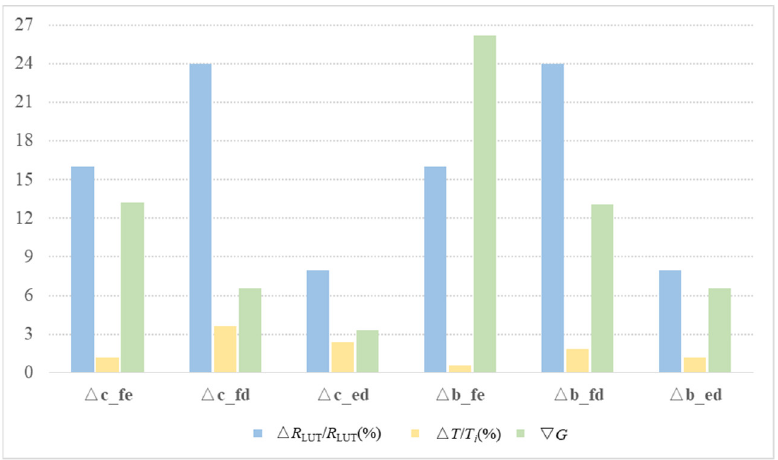
Figure 6. The theoretical analysis of coarse registration with different threads.